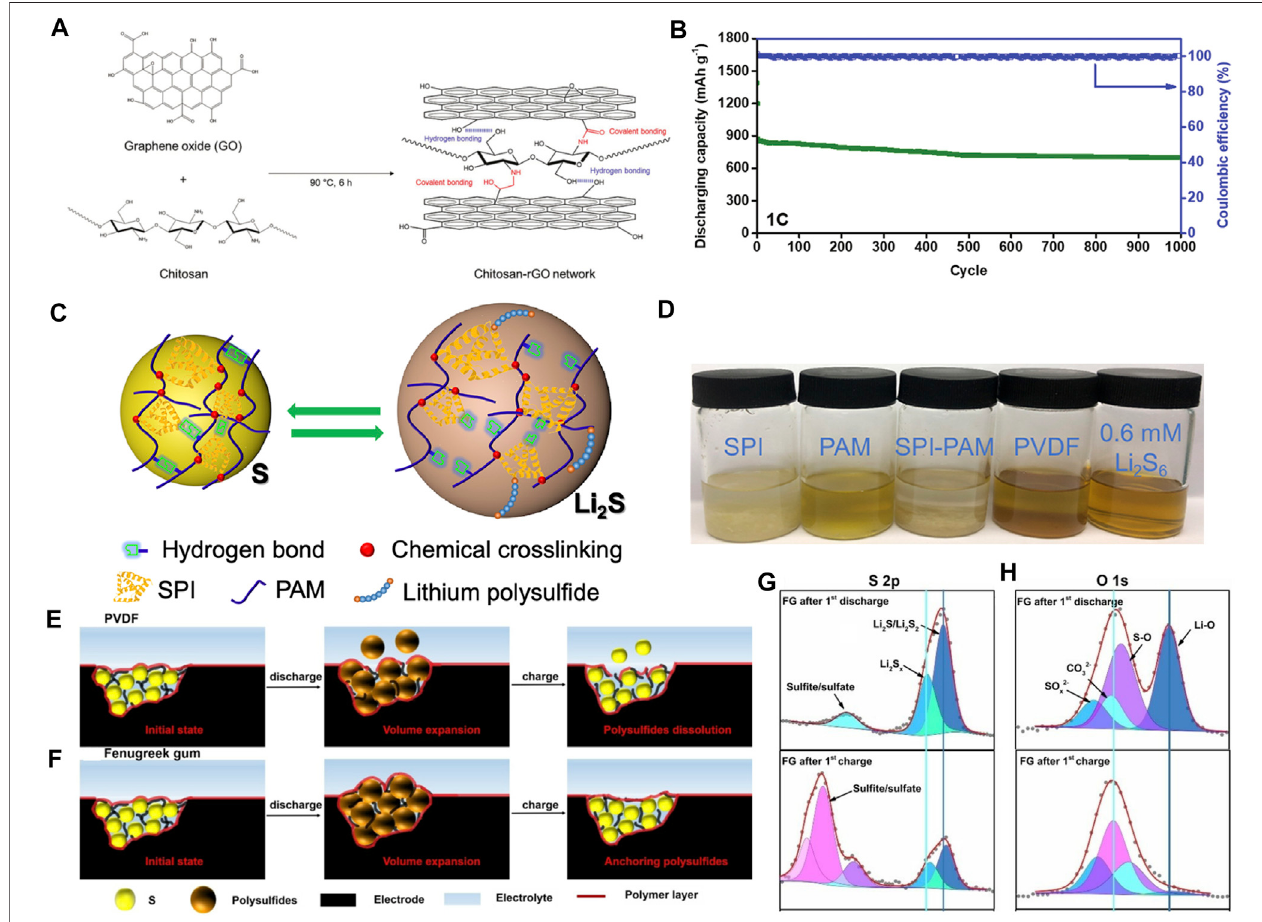
FIGURE 3 | The concepts and mechanisms of organic electrocatalytic binders for Li − S batteries. (A) The formation of networked binders by chitosan and rGO composites. (B) Long-cyclingperformanceofChi-rGO-1-basedLi − Sbatteryat1 C. (A,B) FigurereproducedfromthedatainKimetal.(2020). (C) Schematicdiagrams oftheeffectsofself-healingSPI-PAMadhesives. (D) Visualadsorptionexperimentofdifferentbinderssoakedin0.6 mmolL − 1 ofLi 2 S 6 solution. (C,D) Figurereproduced from the data in Wang H. et al. (2020). (E, F) Morphology evolutions of PVDF and FG binders during cycling. (G, H) O 1s XPS spectra of FG after initial charge/ discharge cycles at 0.1 C. (E – H) Figure reproduced from the data in Mo et al. (2020).